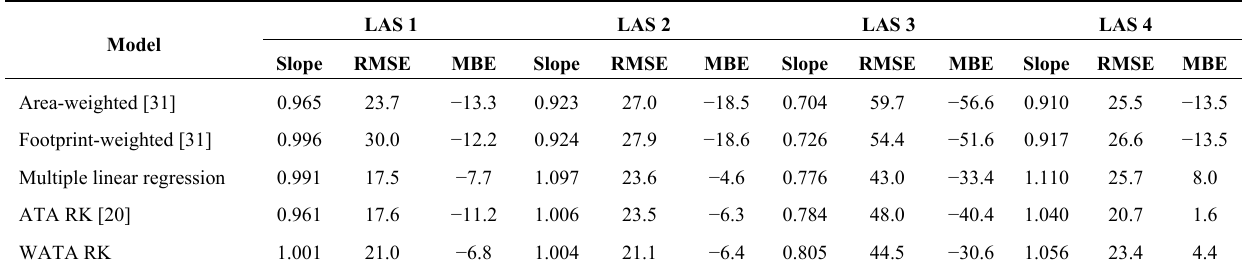
Table 1. Estimated results comparison between different